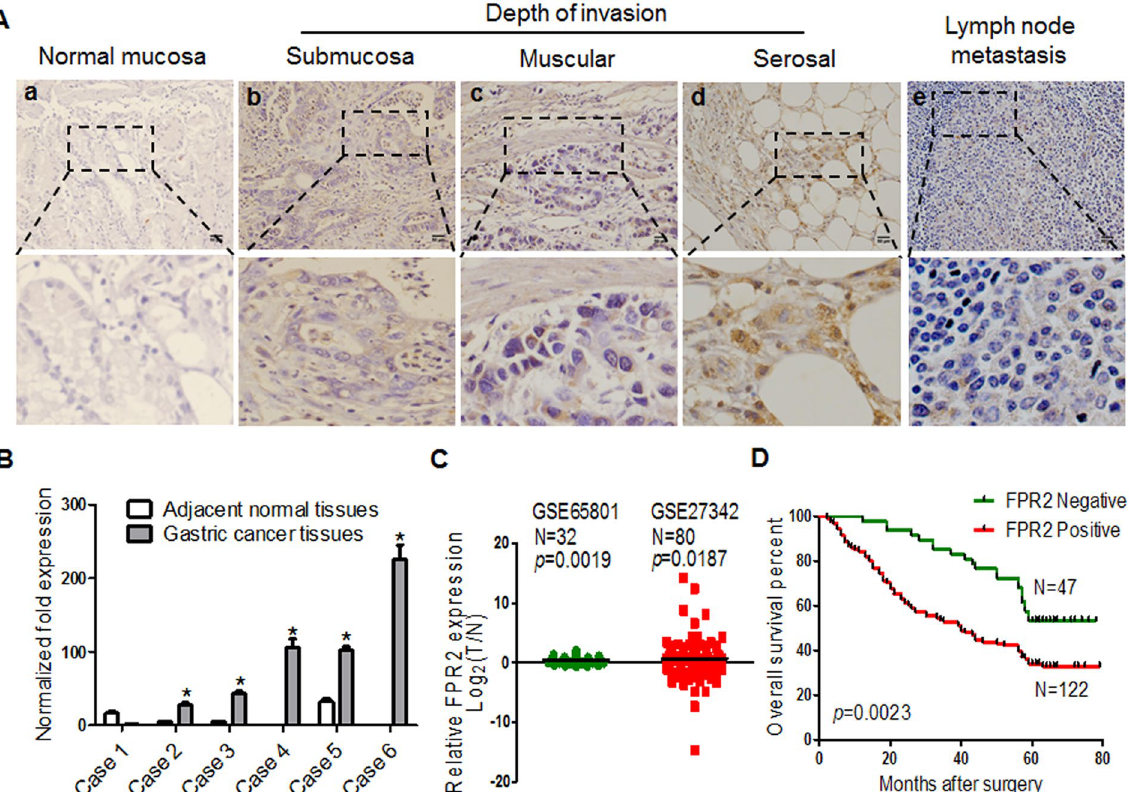
Figure 1. FPR2 expression in gastric cancer tissues is correlated with the clinicopathological characteristics and outcome of GC patients. ( A ) Representative images of FPR2 IHC staining in normal mucosa tissues, GC tissues and metastatic lymph node. (a) FPR2 is negatively or weakly expressed in normal stomach mucosa. (b–d) The levels of FPR2 expression are elevated with the invasion depth in GC tissues. (e) GC metastatic focus of lymph node showing FPR2 positive staining. ( B ) Quantitative analysis of FPR2 mRNA in 6 fresh surgical tumor specimens and paired adjacent normal tissues. ( C ) The mRNA expression of FPR2 in gastric cancer and paired normal adjacent tissues from 2 reported datasets. ( D ) Kaplan-Meier overall survival curves of 169 GC patients indicates that FPR2 + patients hold shorter life time -then FPR2 − patients ( p = 0.0023). Scale bar = 50 μ